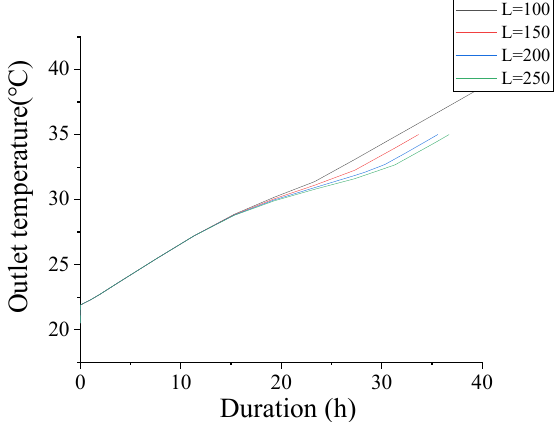
Figure 10. Effect of latent heat on the outlet temperature of the reservoir. Combining Figures 7 and 10, it can be seen that similar to the influence of differ- ent phase transition temperatures on the outlet temperature of the reservoir, The outlet temperature of the reservoir under different latent heat values also presents three stages: the first stage of heat storage is dominated by sensible heat; the second stage of heat storage is dominated by latent heat from the changing phase; and the third stage of heat storage is dominated by sensible heat. The slope change stage of the temperature rise curve is the